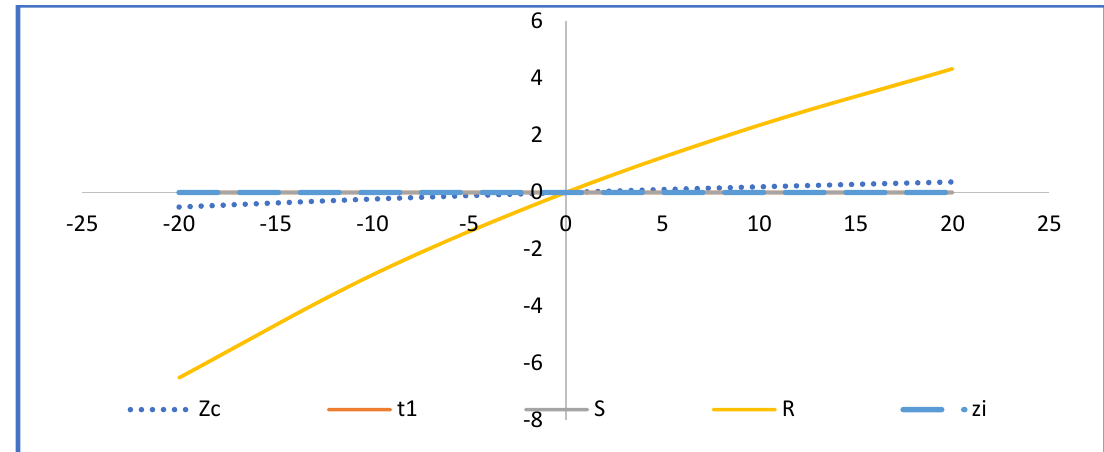
t , S , R , and ξ . 1 1 1